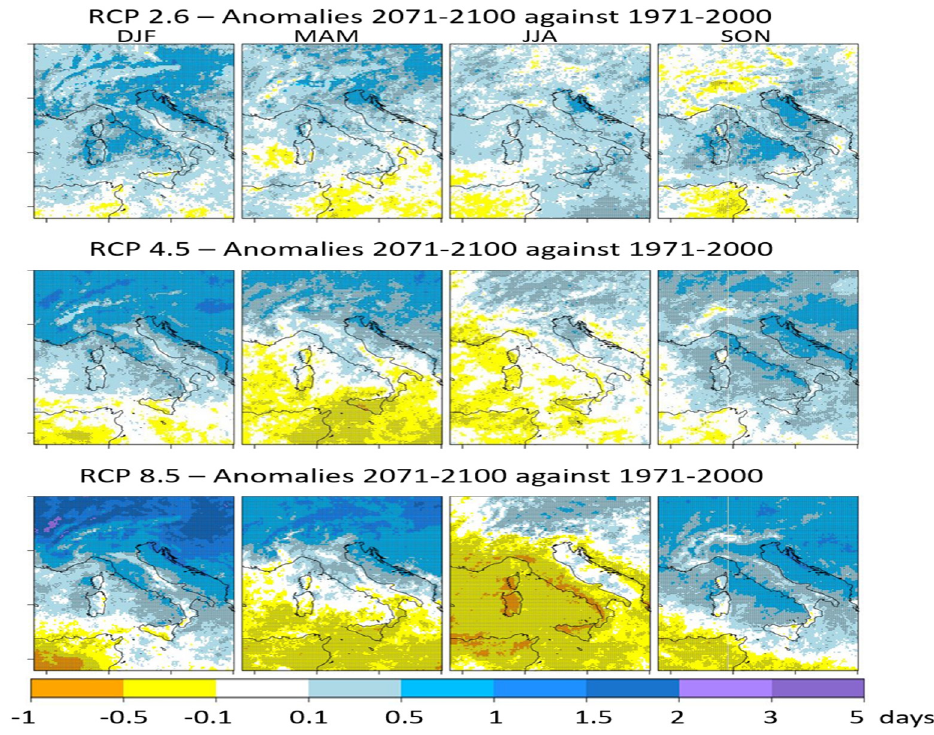
Figure 16. As Figure 14, but for the future scenario 2071–2100.